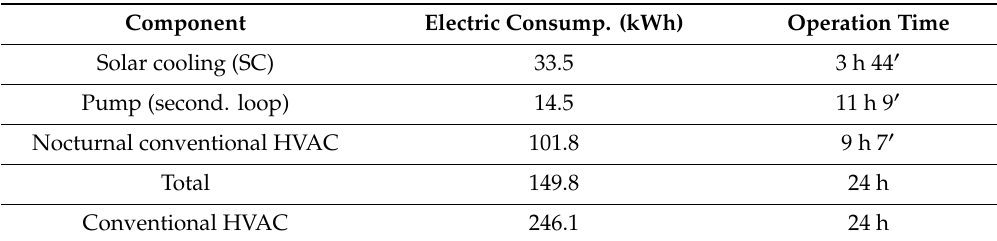
Table 4. Average daily consumption of the solar driven cooling system and operation times of every component. A conventional refrigeration system is included for comparison in the last